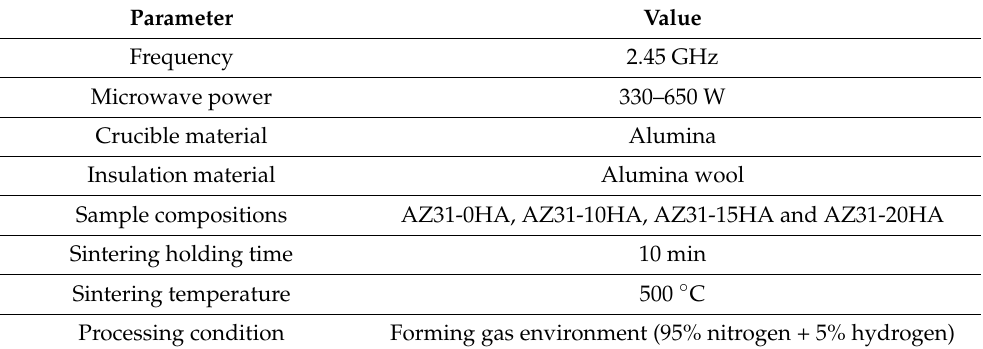
Table 2. Details of processing conditions used in microwave sintering of AZ31-HA